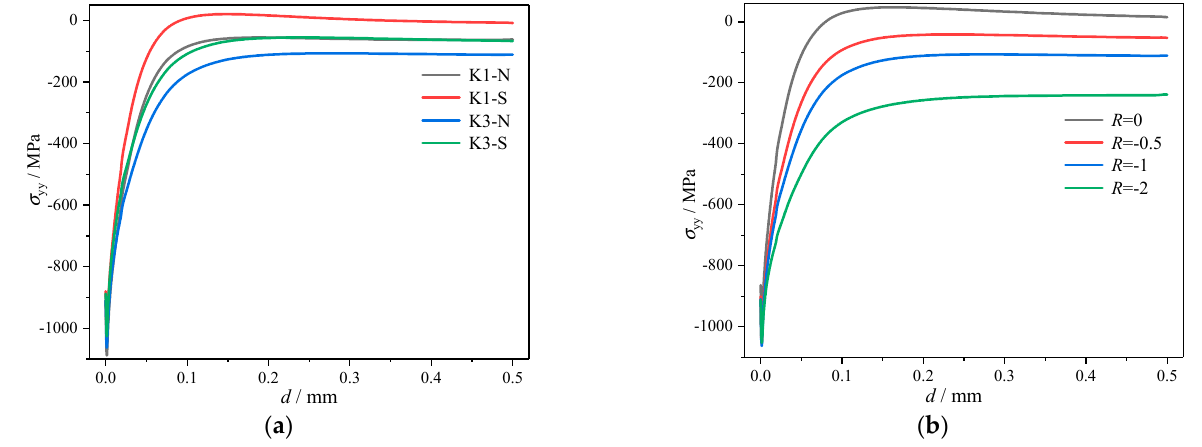
Figure 6. Normal stresses σ yy with d : ( a ) effect of specimen type, ( b ) effect of loading ratio.